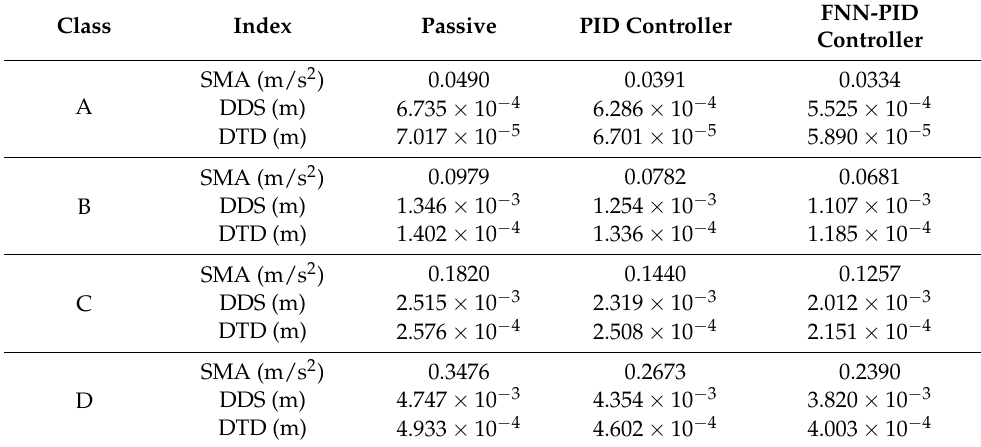
Table 4. Root mean square comparison of suspension performance indexes under random.